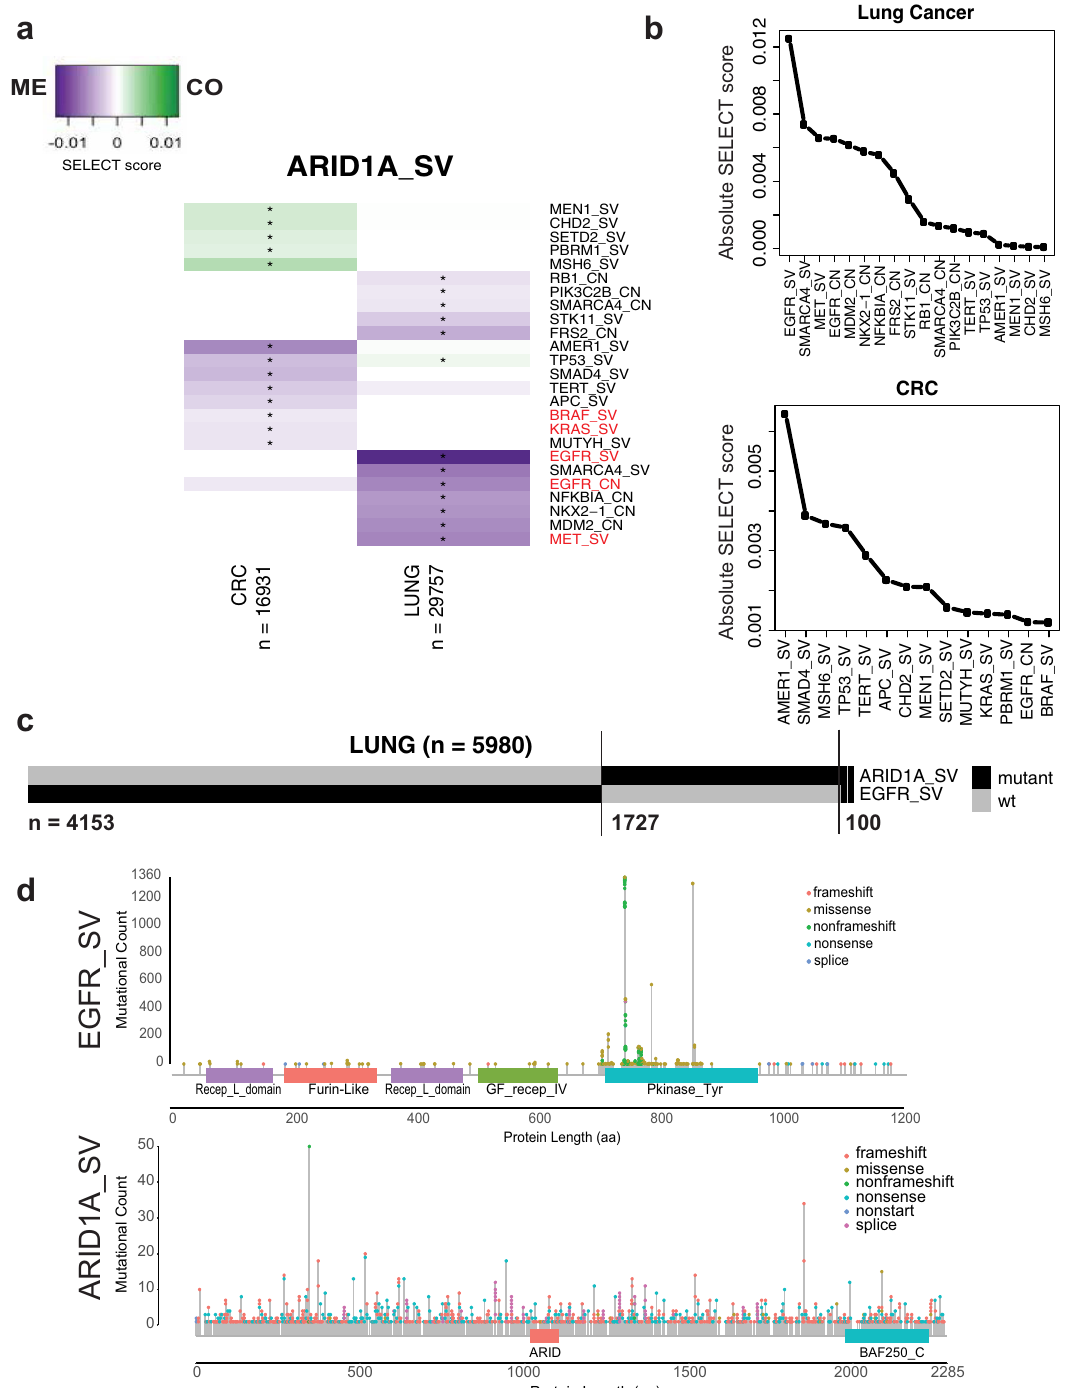
for the SELECT analysis. Asterisks indicate signi fi cant relationships (FDR<0.1). b Overviewofsigni fi cantinteractionswithARID1ASVsdetectedinlungcancer( top ) and CRC ( bottom ), ranked by SELECT scores. c Mutation occurrences for 5980 patients with ARID1A and/or EGFR mutations in the FMI lung cancer cohort. d Overview of known and likely EGFR( top ) and ARID1A ( bottom ) mutations in lung cancer patients. aa amino